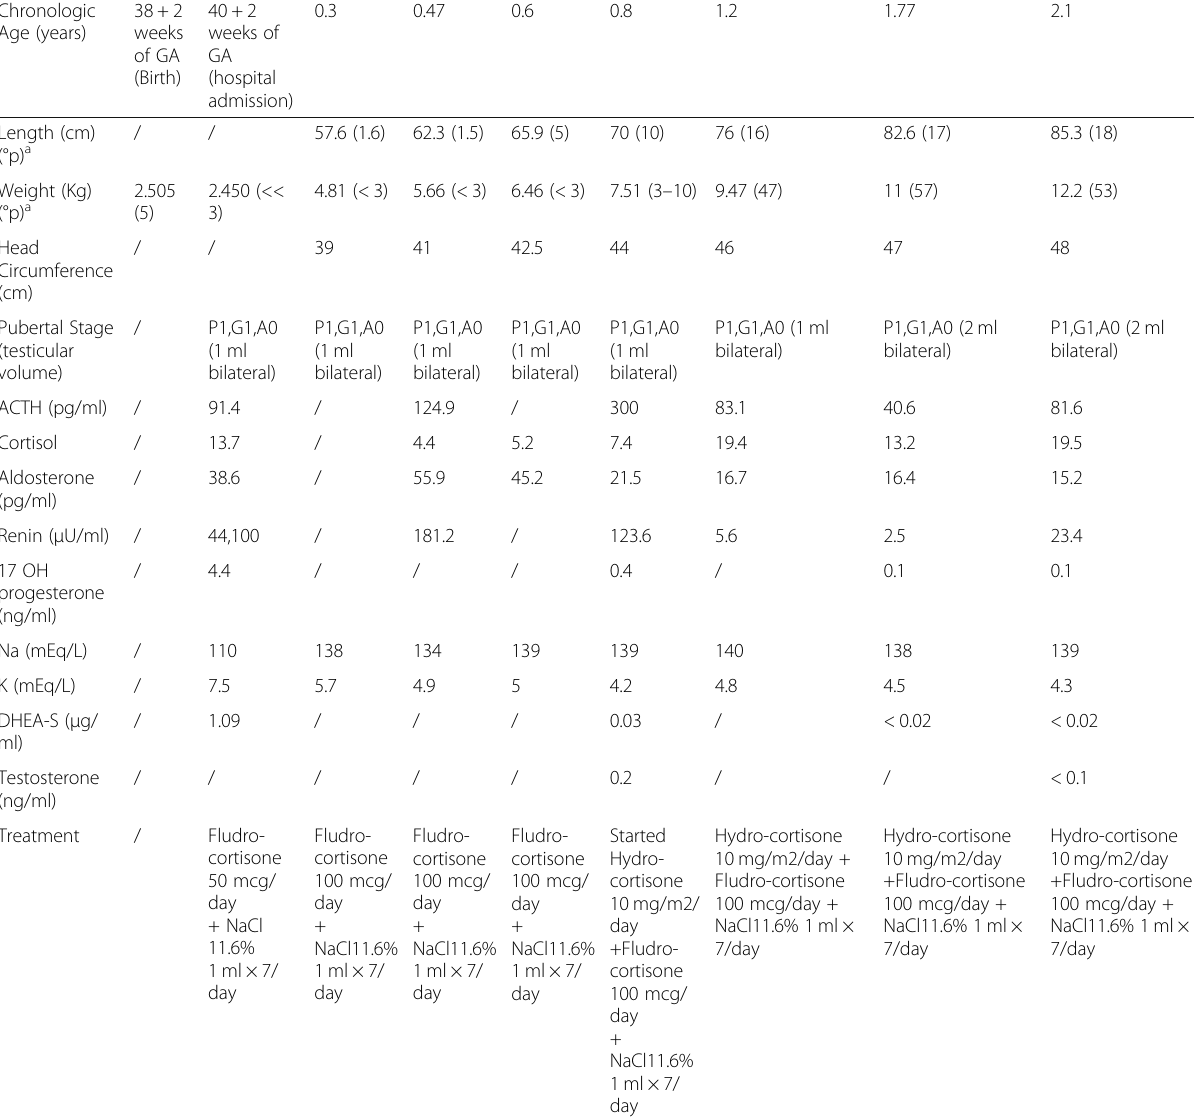
Table 1 Medical history timeline where auxological parameters during the first 2 years of life and biochemical and hormonal values are summarized.